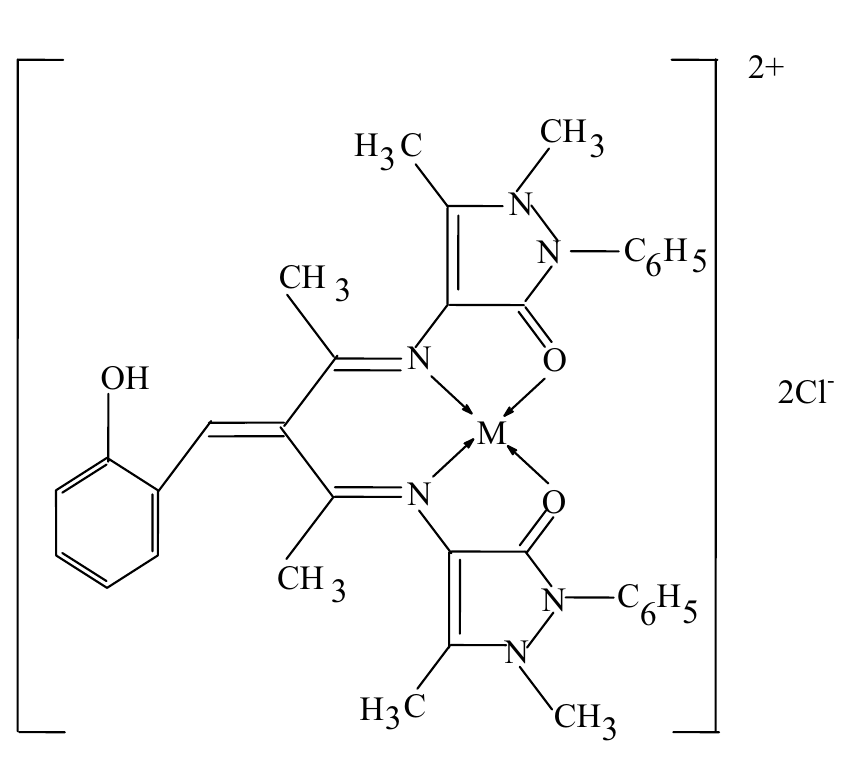
Fig. 1 Structure of the metal complexes, where M = Cu(II), Ni(II), Co(II) and